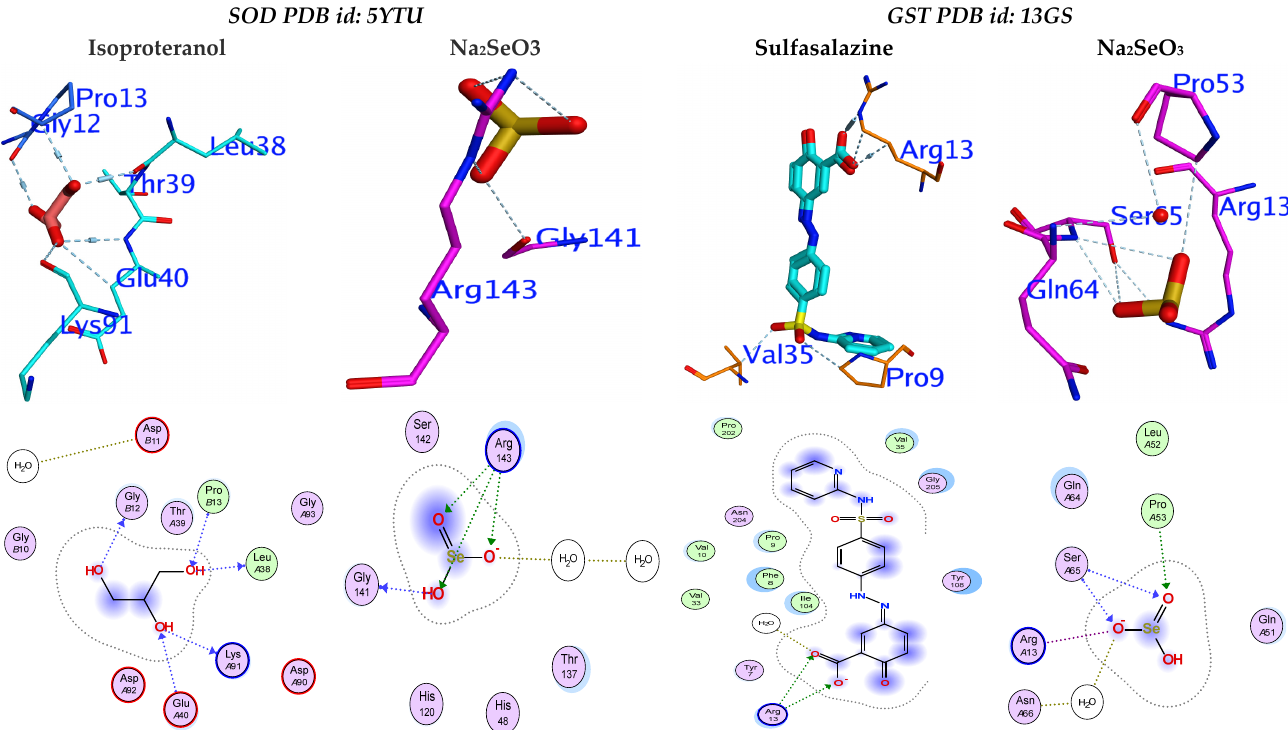
Figure 10. 2D and 3D docked interaction map for the Na 2 SeO 3 compounds into the active site of SOD and GST.